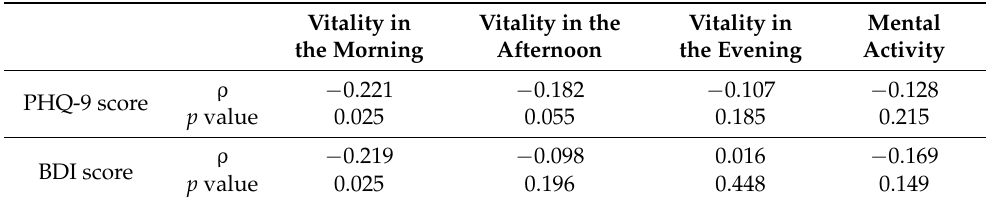
Table 2. Correlation between score of self-report psychological questionnaire and vitality or mental activity. Vitality in Vitality in the Vitality in Mental the Morning Afternoon the Evening Activity ρ − 0.221 − 0.182 − 0.107 − 0.128 PHQ-9 score p value 0.025 0.055 0.185 0.215 ρ − 0.219 − 0.098 0.016 − 0.169 BDI score p value 0.149 Spearman’s rank correlation coefficient.